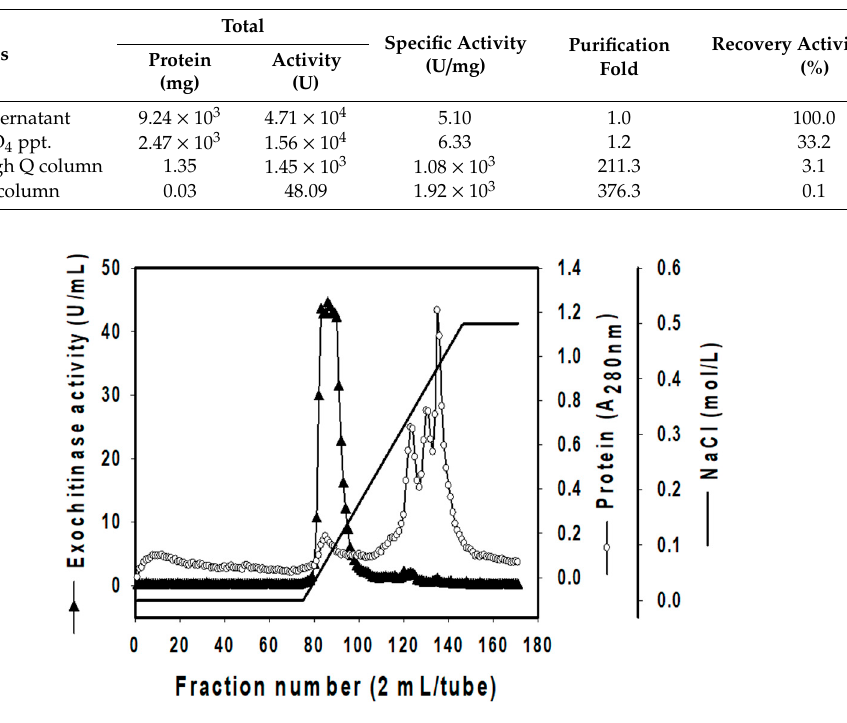
Figure 2. A typical ion-exchange chromatography profile of S. speibonae TKU048 exochitinase on Macro-Prep High Q. The elution was performed using Tris-HCl buffer system (20 mM, pH 7) with a NaCl gradient from 0 to 0.5 M and 2.5 mL of flow rate. Fifty microliters of each tube were withdrawn to test the exochitinase activity. The exochitinase activity fraction was found from tubes 80 to 91.